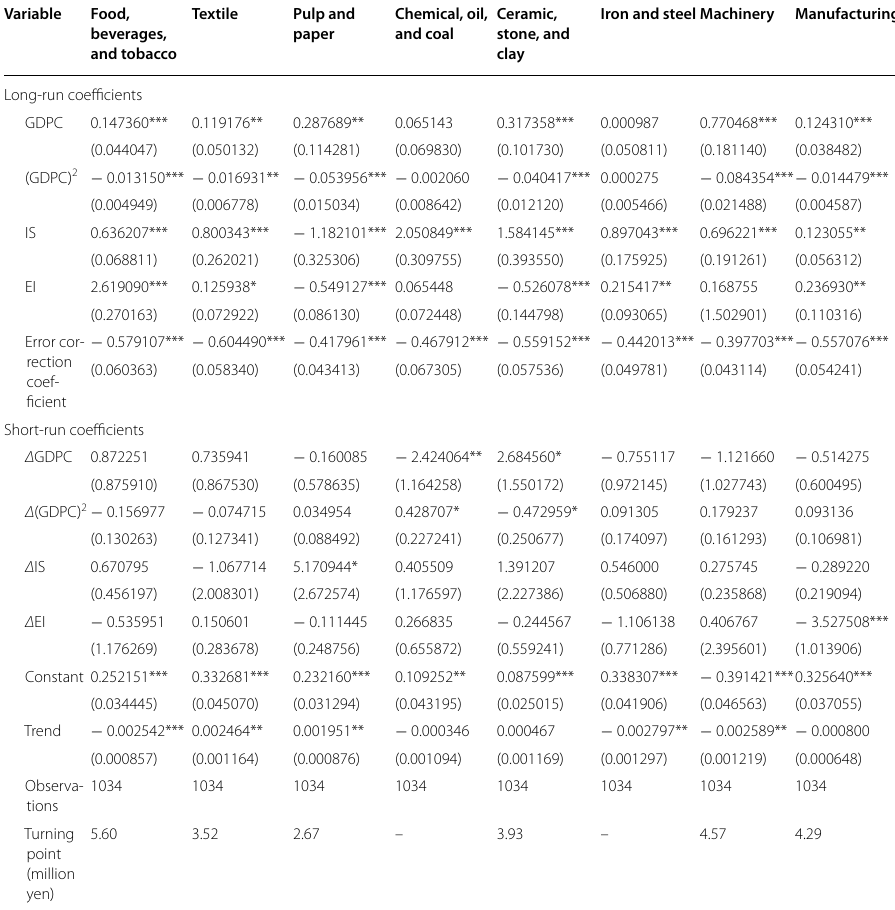
Table 7 Pooled mean group (PMG) estimation results in the EEE1